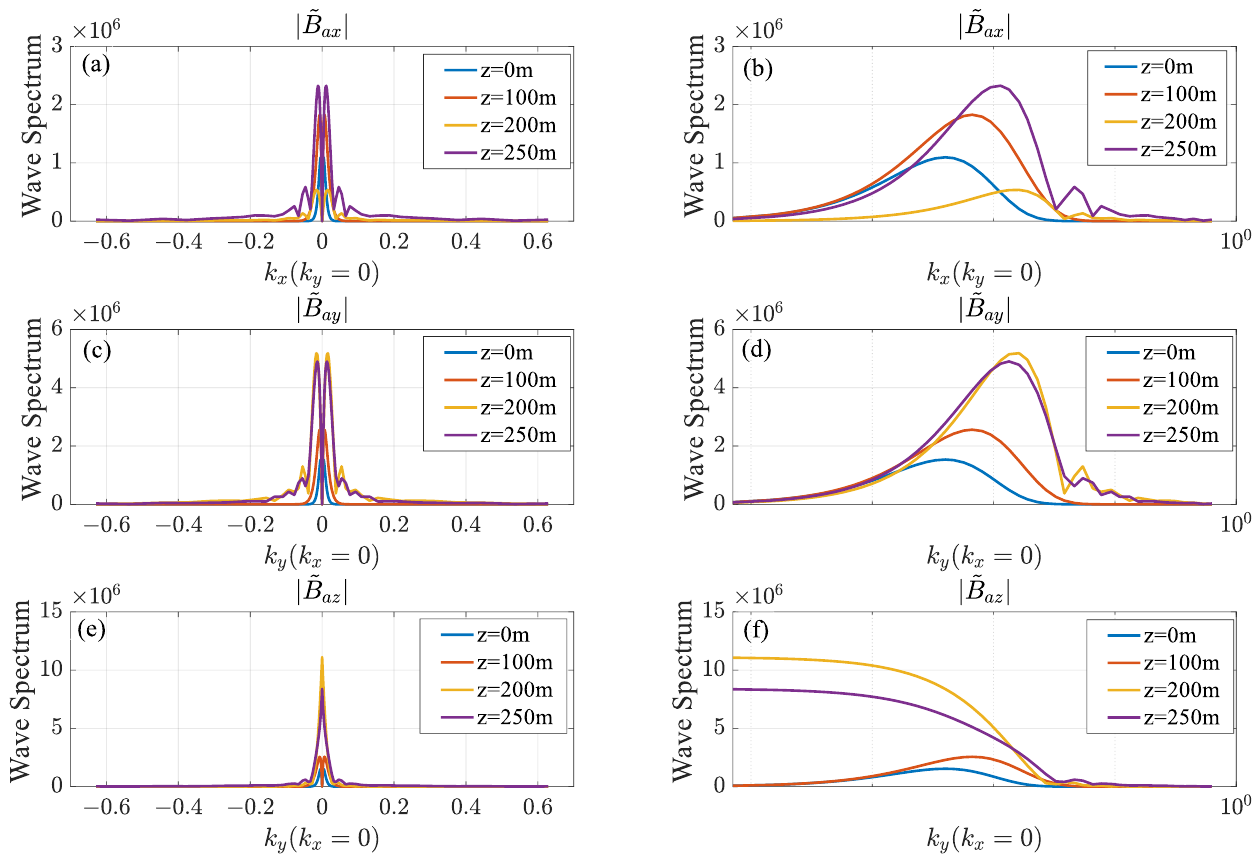
Figure 11. Spectrum distribution of weak magnetic field at different depths. The horizontal ordinate of figures ( a , c , e ) is non-logarithmic, and the horizontal ordinate of figures ( b , d , f ) is logarithmic.